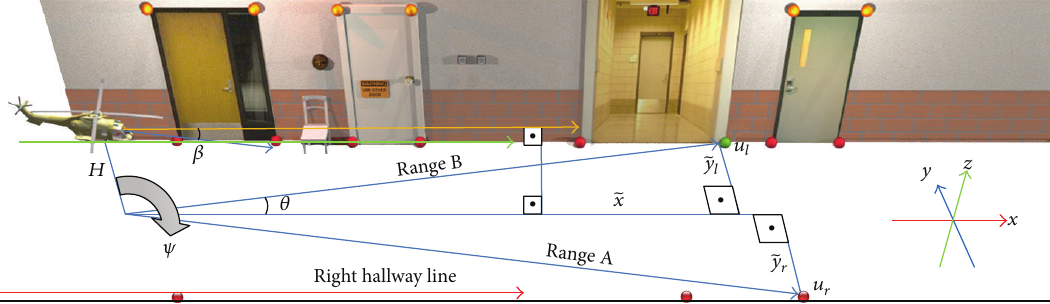
Figure 1: A three-dimensional representation of the corridor with respect to the MAV. Note that the width of the hallway is not provided to the algorithm and the MAV does not have any sensors that can detect